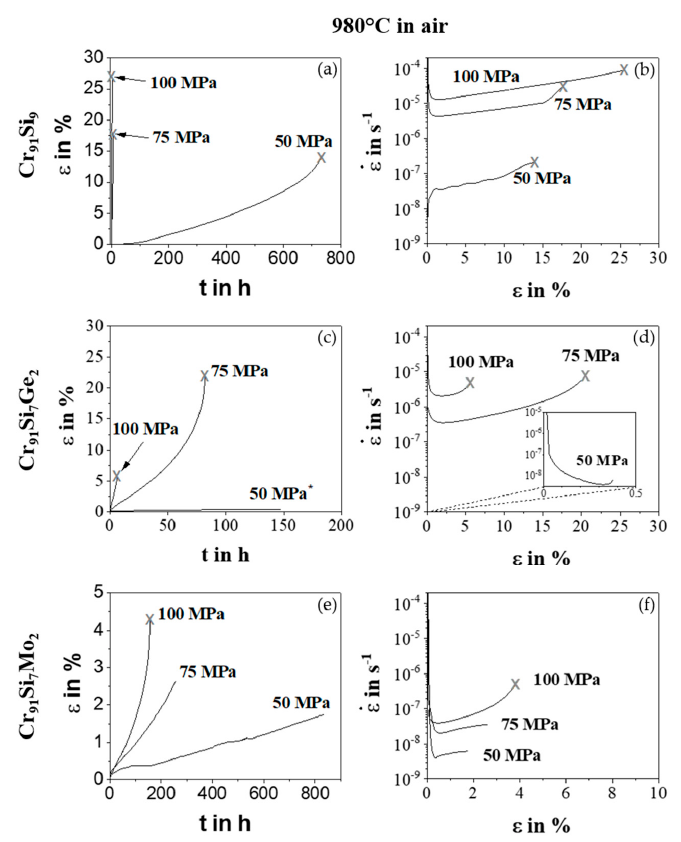
Figure 2. Creep curves ɛ vs. t and ε (cid:4662) vs. ɛ at 980 °C in air of the alloys Cr 91 Si 9 ( a , b ), Cr 91 Si 7 Ge 2 ( c , d ) and Cr 91 Si 7 Mo 2 ( e , f ). Fractured samples are highlighted with an X at the end of the curve. In case there is no symbol, the test was aborted.